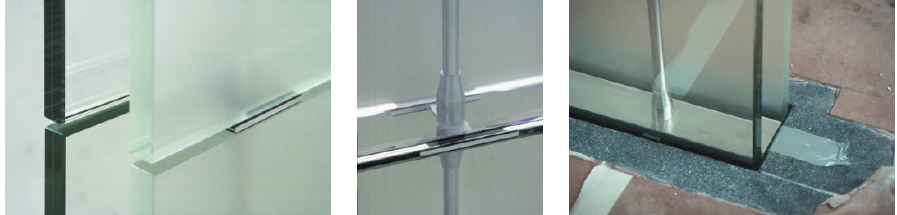
Figure 5a, b, c: details showing the center rods, glass connections, laminated panels and base